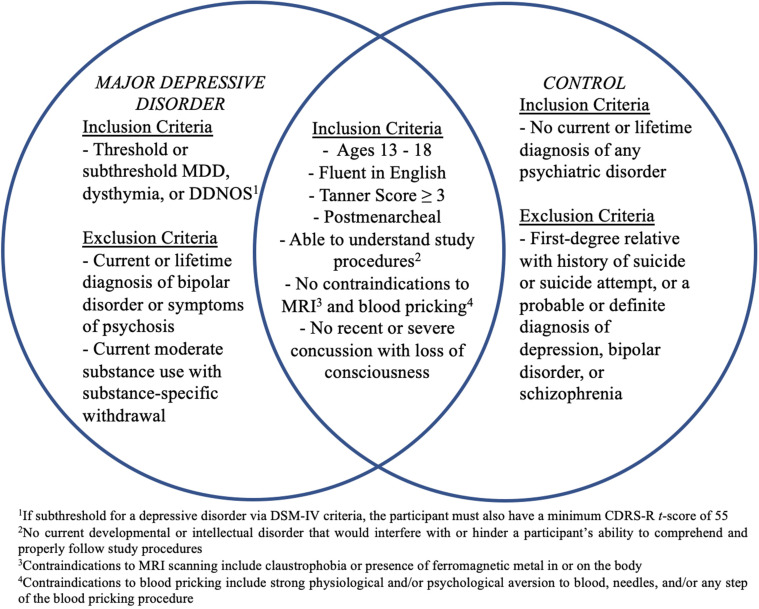
Inclusion and exclusion criteria for participants with Major Depressive Disorder (MDD) and healthy controls. CDRS-R, Children’s Depression Rating Scale-Revised; DDNOS, depressive disorder not otherwise specified; MDD, Major Depressive Disorder; MRI, magnetic resonance imaging.